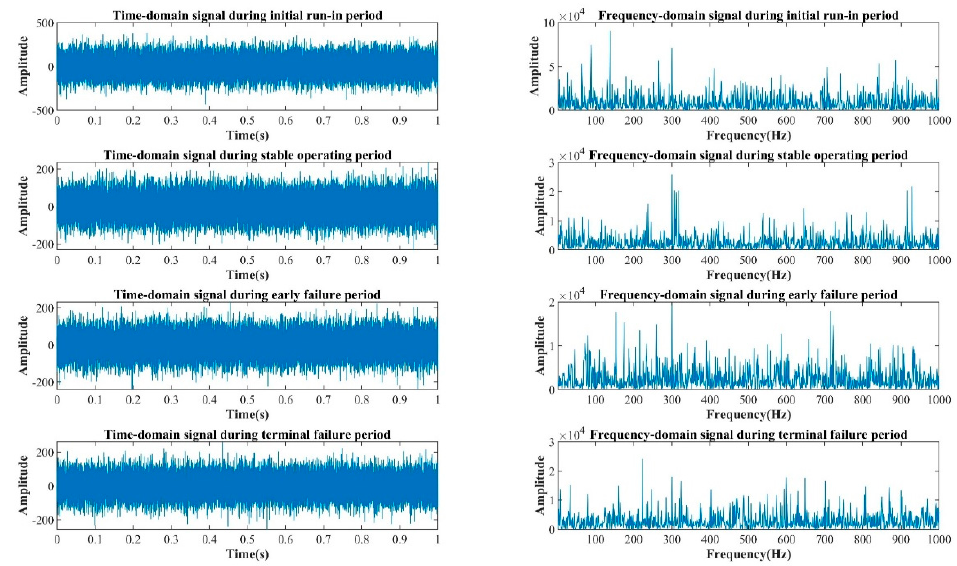
Figure 6. Raw signals of the internal gear pump in four operating periods.